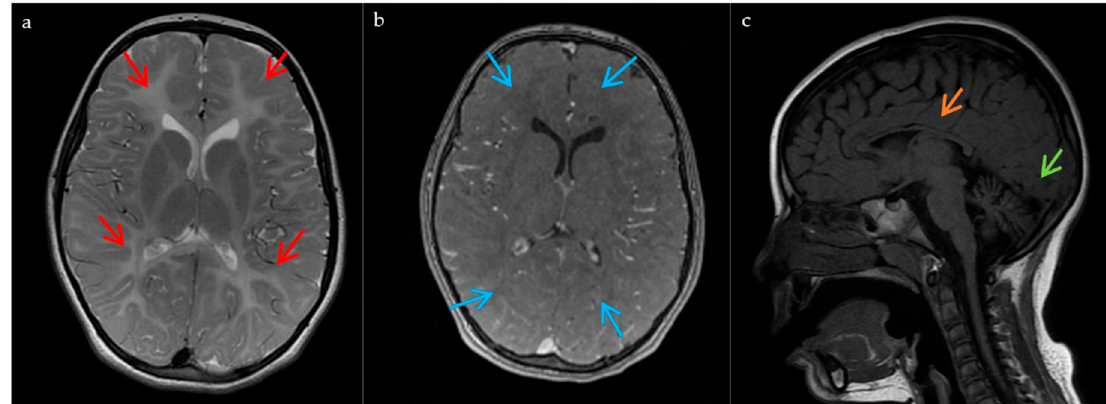
Figure 1. MRI findings in the patient. These images, obtained at the age of 7, show: ( a ) Hypomyelination process with diffuse hyperintensity of the supratentorial and cerebellar white matter on the T2-weighted images (red arrows); ( b ) T1 diffuse isointensity of the supratentorial white matter on the T1 sequences (blue arrows); ( c ) Cerebellar atrophy (green arrow), and a thinned corpus callosum (orange arrow).